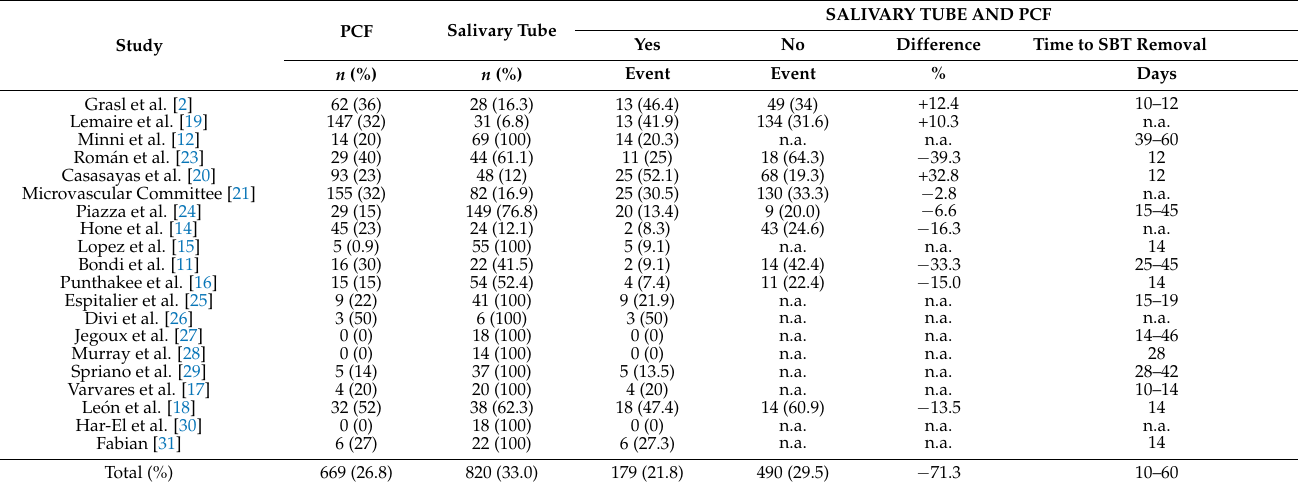
Figure 2. Pharyngocutaneous Fistula. The pharyngocutaneous fistula (PCF) rate is illustrated according to whether or not salivary tube was applied. PCF rate was lower but not significantly different in patients who received salivary tubes compared to those without (22.2 ± 18.4% vs. 35.3 ± 16.1%). Box-plots display means and corresponding 95% confidence intervals. Table 3. Pharyngocutaneous fistula and salivary tube.